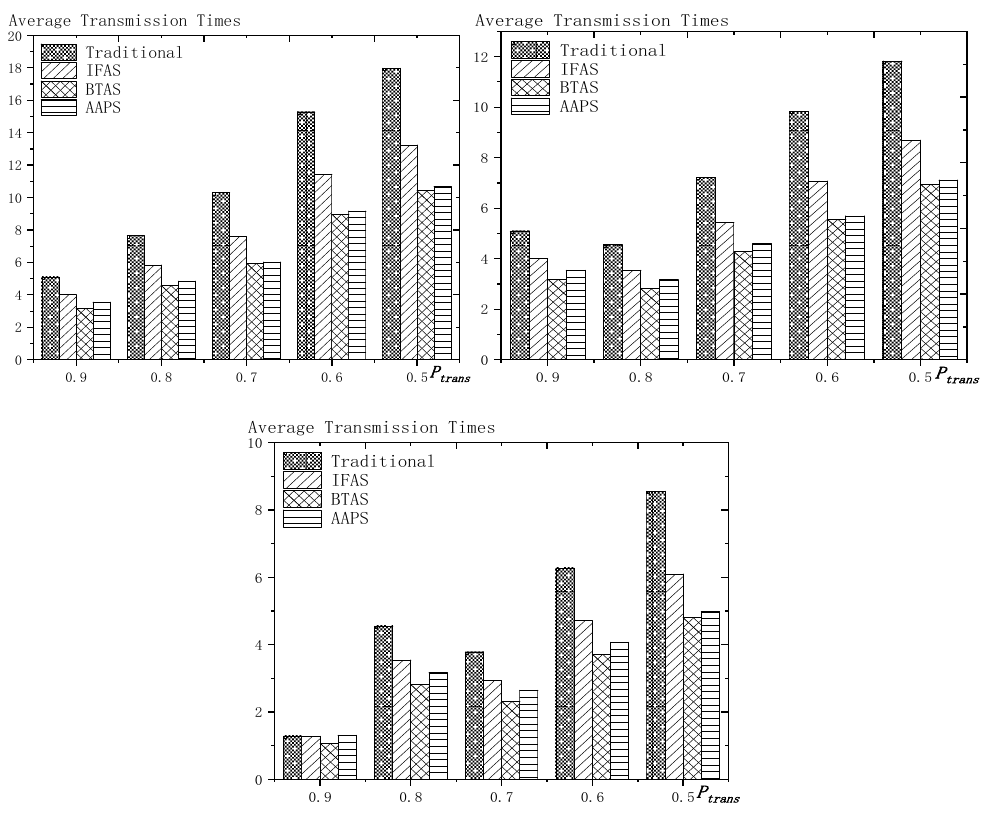
Figure 22. The average transmission times with P trans as variable (setting 1, setting 2, setting 3). Table 13. The improvement of transmission times compared with the traditional algorithm. (cid:2172) (cid:2202)(cid:2200)(cid:2183)(cid:2196)(cid:2201)